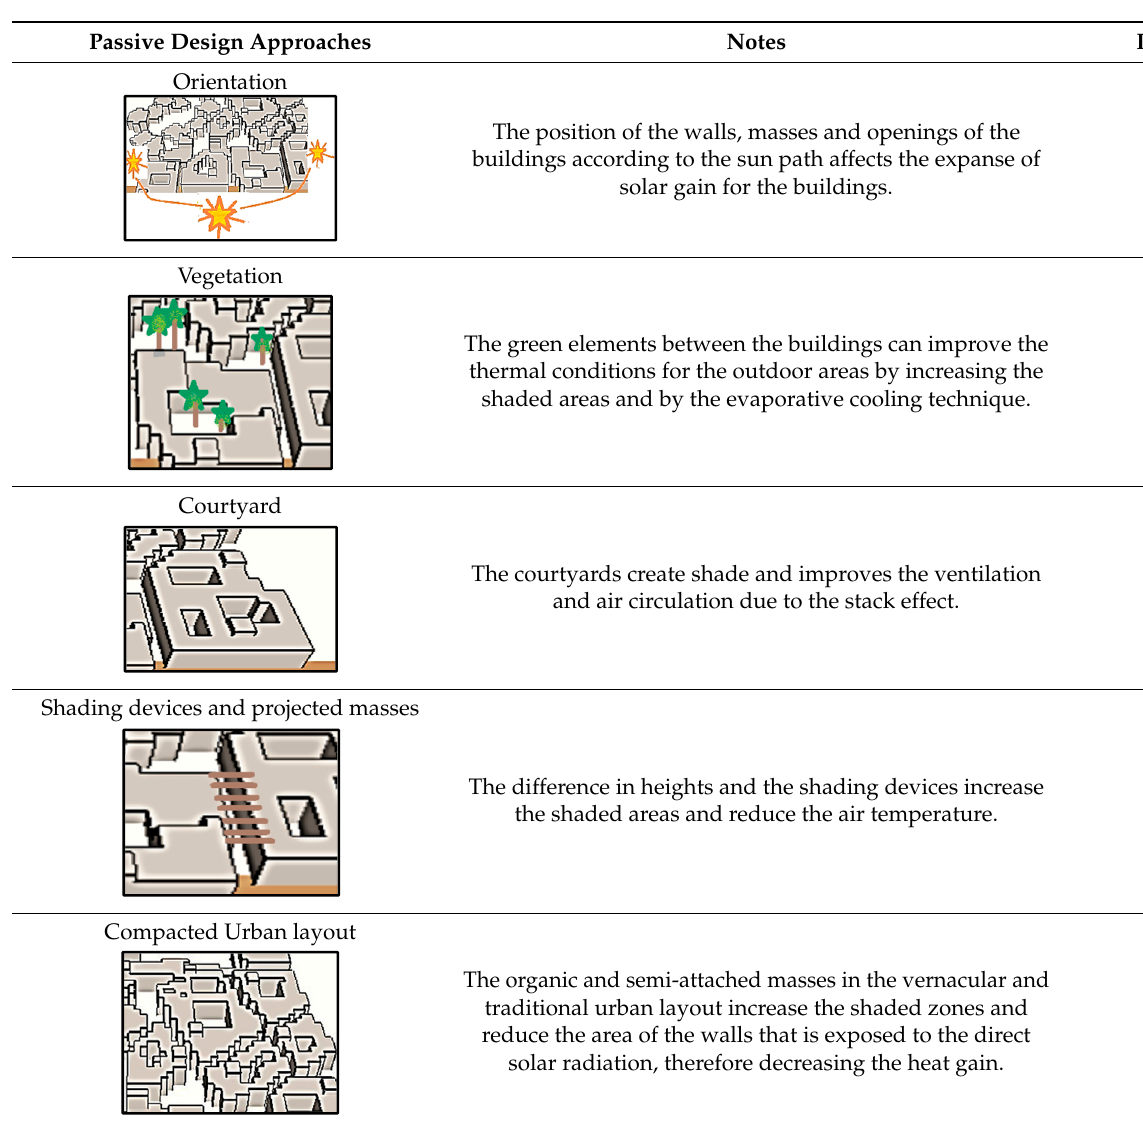
Table 1. Examples of passive design Table 1. Examples of passive design approaches. Table 1. Examples of passive design approaches. Table 1. Examples of passive design approaches. Table 1. Examples of passive design approaches. Table 1. Examples of passive design approaches.